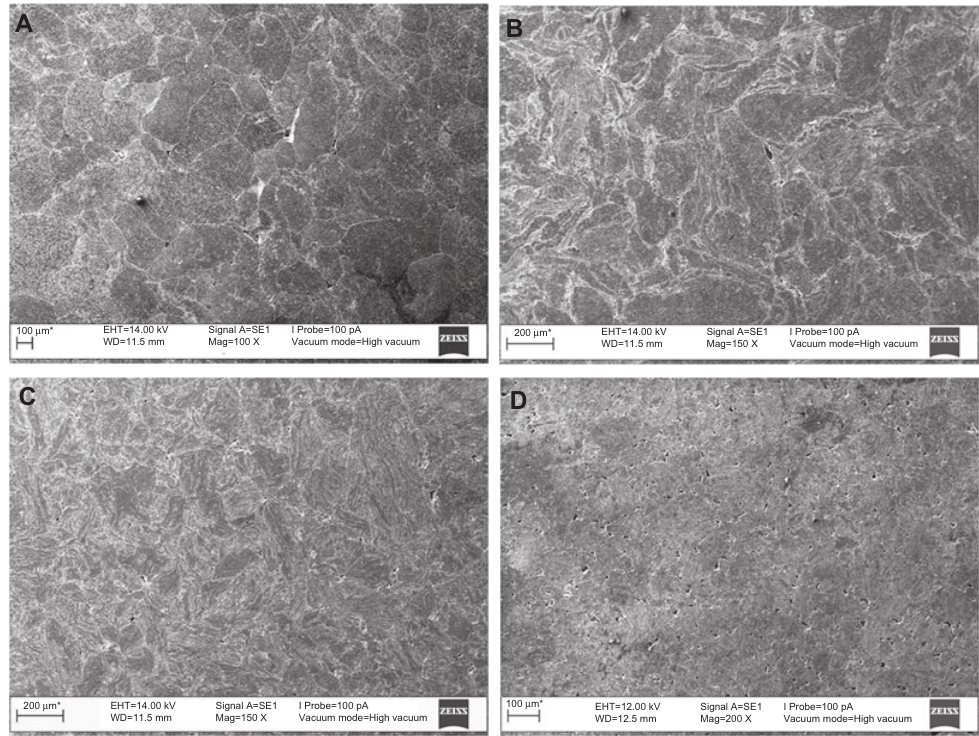
Figure 9 SEM micrographs of unreinforced Al powders after (A) 0 h, (B) 0.5 h, (C) 2 h, (D) 7 h of milling.